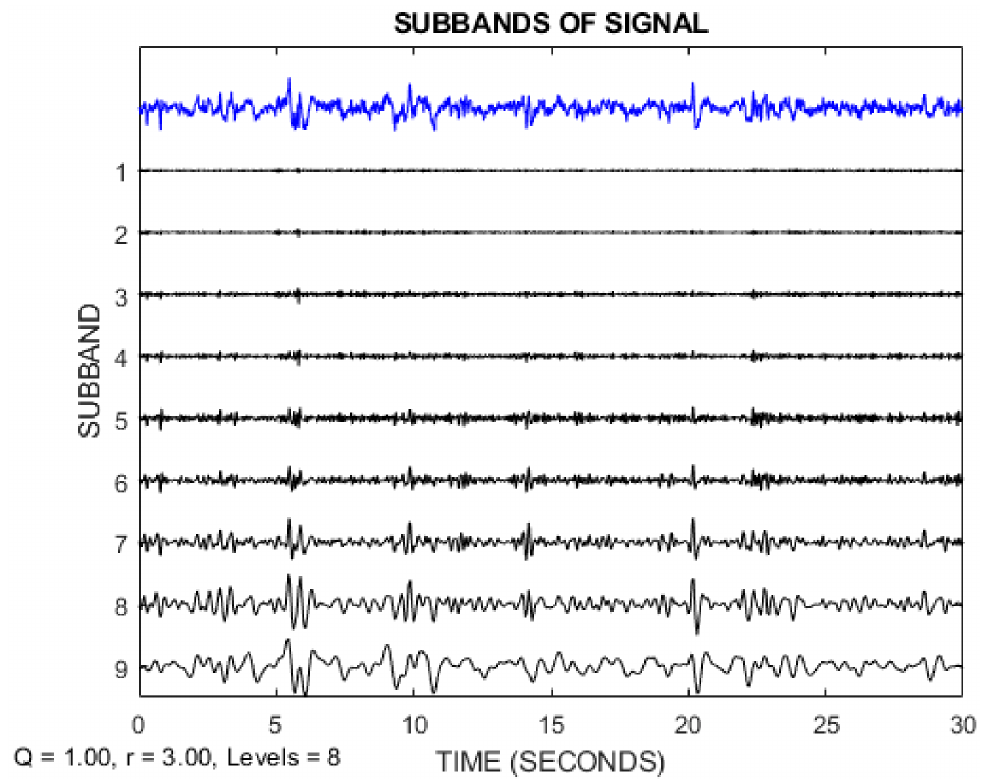
Figure 4. EEG signal decomposition using TQWT for the Freiburg